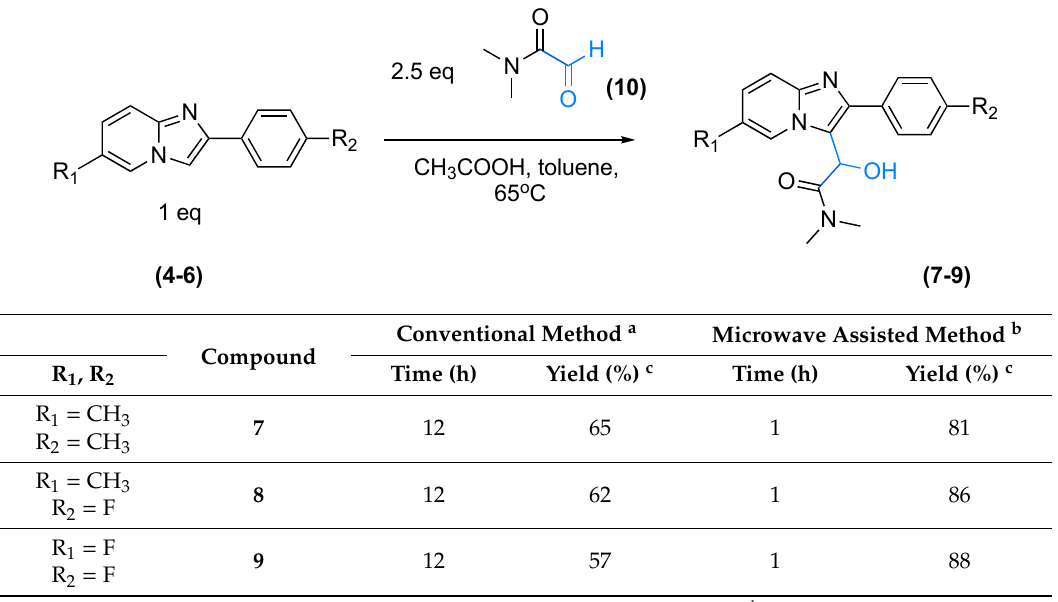
Table 3. Functionalization of 2-phenylimidazo[1,2-a]pyridines with of N , N -dimethylglyoxylamide under MW compared with traditional heating systems conditions.